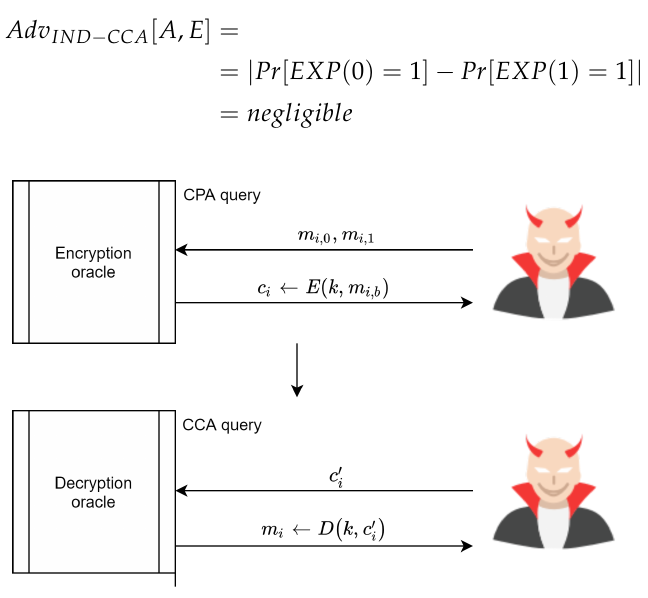
Figure 24. An adversary’s power to submit countless messages to the encryption oracle in